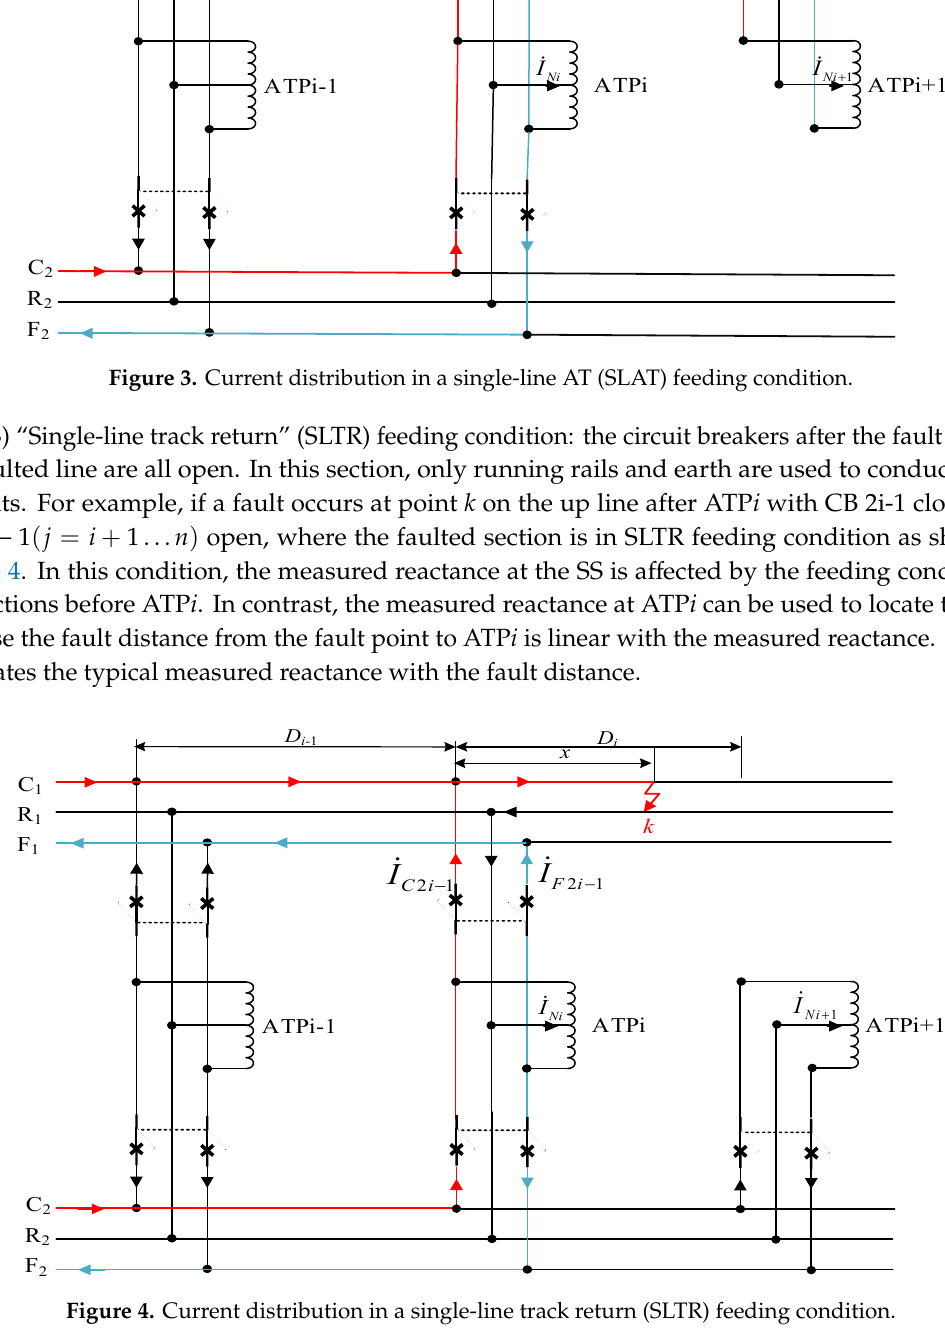
Figure 4. Current distribution in a single-line track return (SLTR) feeding condition.